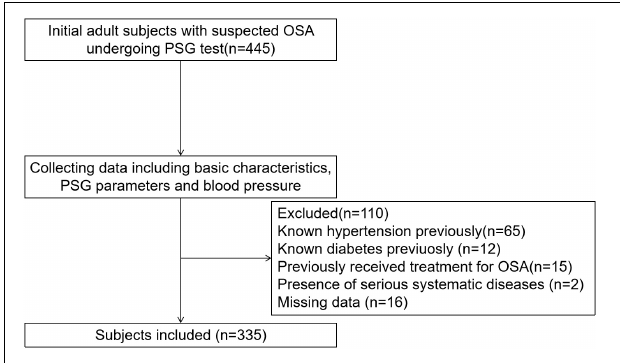
FIGURE 1 | Enrollment flow chart for the study population. OSA, obstructive sleep apnea; PSG, polysomnography.